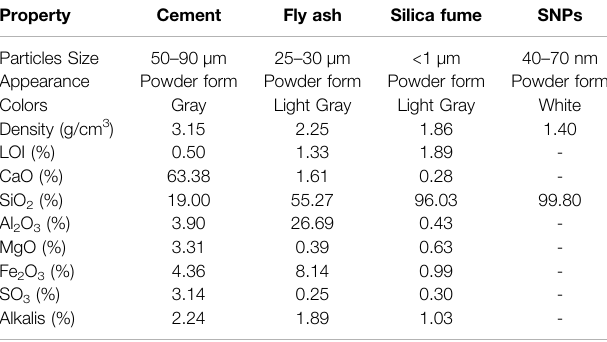
TABLE 1 | Physio-chemical properties of cement, fl y ash, SNPs, and silica fume.